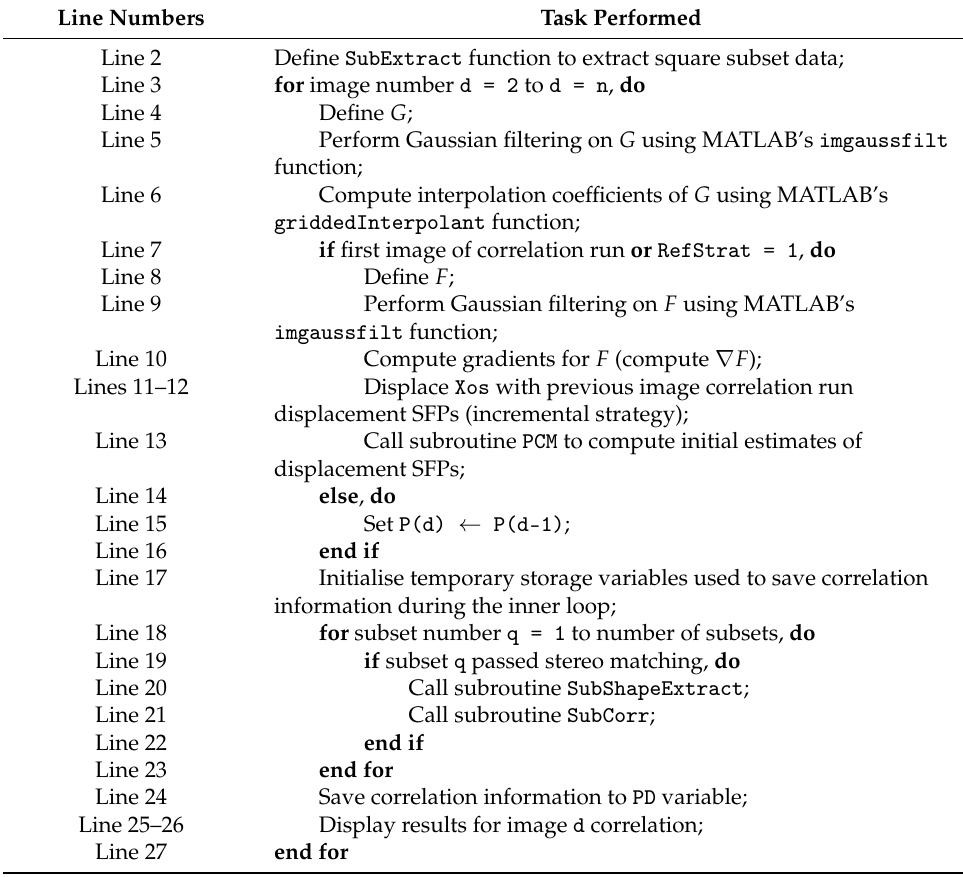
Table 12. ImgCorr algorithm